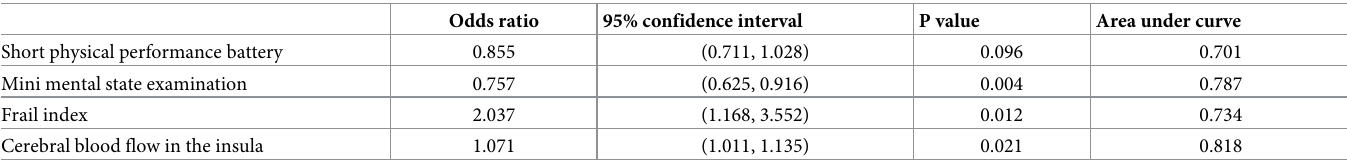
Table 4. Results of univariable regression analyses with delirium as an